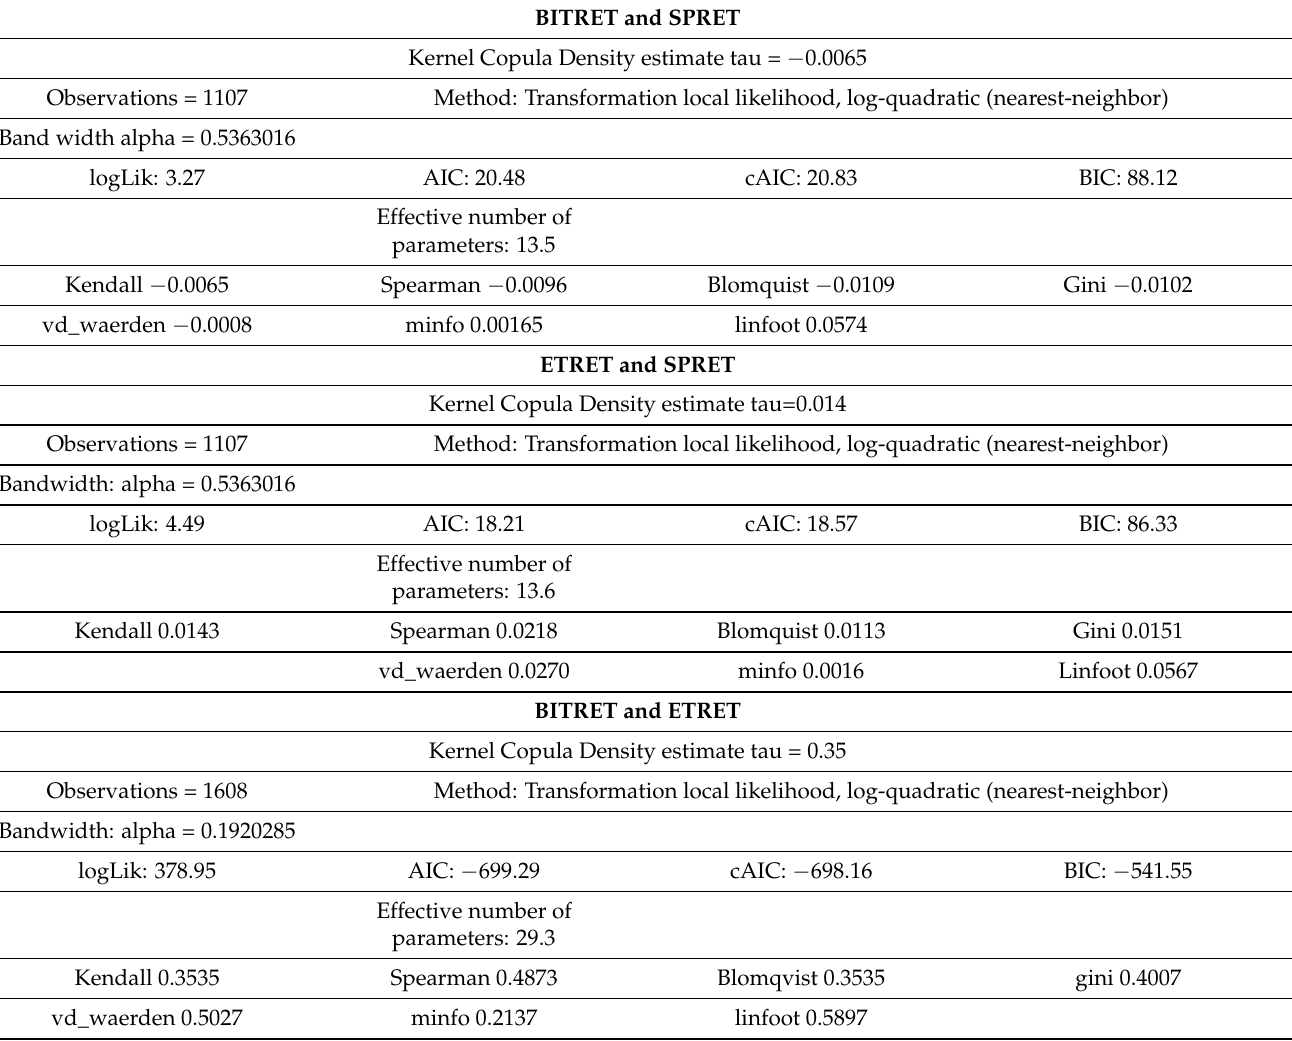
Table 8. Non-parametric copula-estimation-transformed returns Period